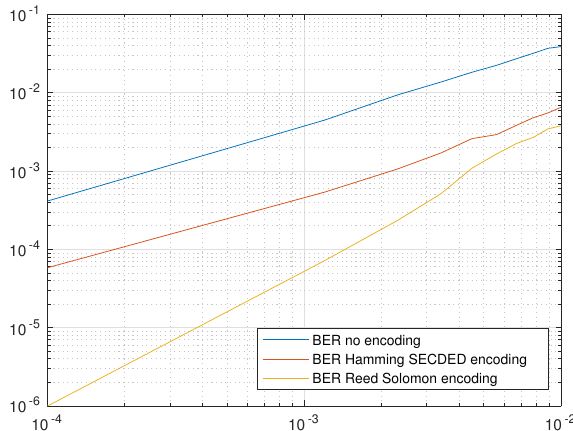
Figure 11. BER (Bit Error Ratio) as a function of error probability for a BSC (Binary Simmetrical Channel)